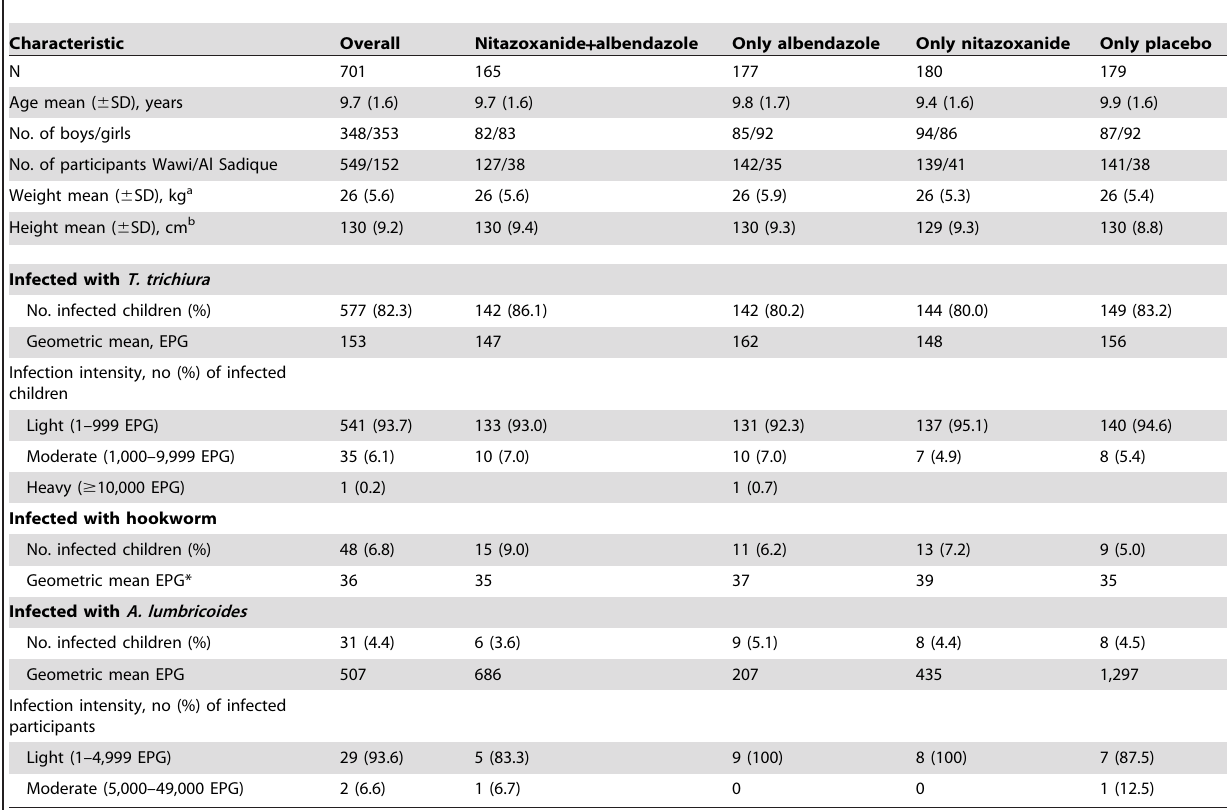
Table 1. Baseline characteristics of school-aged children included in the